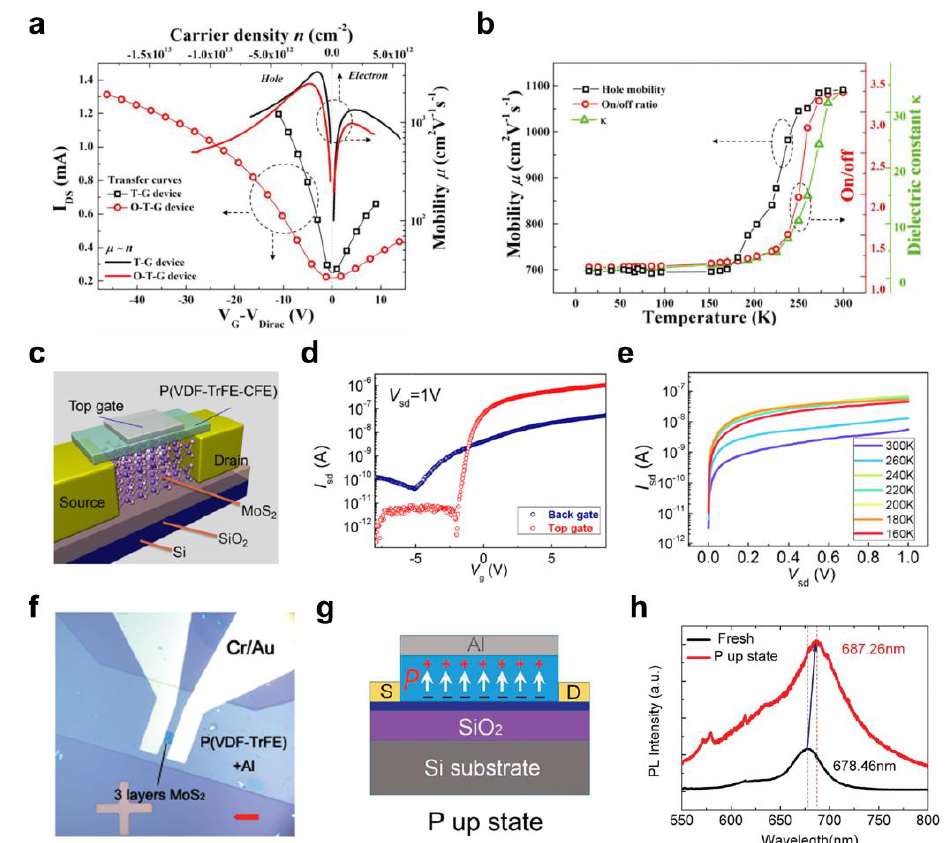
Figure 6. ( a ) I D vs. V G − V Dirac transfer curves for the graphene FETs with the P(VDF − TrFE − CFE) single − layer dielectric (T–G device) and with the P(VDF − TrFE − CFE)/SiO 2 bilayer dielectric (O–T–G device). ( b ) The change in the µ and I on / I off for the graphene T–G device, and the dielectric constant of the P(VDF − TrFE − CFE) in relation to the temperature [124]. Copyright © 2020, John Wiley and Sons. ( c ) Schematic illustration of 2D MoS 2 FETs with the P(VDF − TrFE − CFE) dielectric layer fabricated on SiO 2 /Si substrate and ( d ) their transfer characteristics. ( e ) Change in output characteristics in relation to the temperature for the top − gate 2D MoS 2 FETs with the P(VDF − TrFE − CFE) dielectric layer [125]. Copyright © 2016, American Chemical Society. ( f ) Optical microscope image of the photodetector device containing three − layered MoS 2 and P(VDF − TrFE) and ( g ) the schematic diagram of the device with negative V G applied (P up state). ( h ) The PL spectrum of 2D MoS 2 in P up state compared to that without an external electric field (fresh) [126]. Copyright © 2015, John Wiley and Sons.